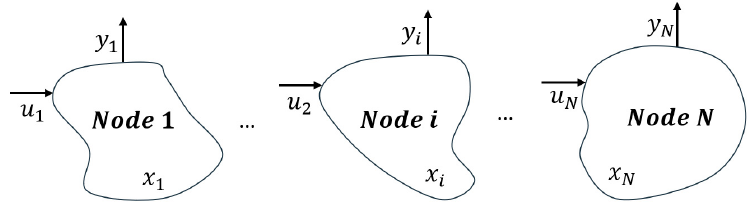
Figure 2. General network of N nodes. According to the